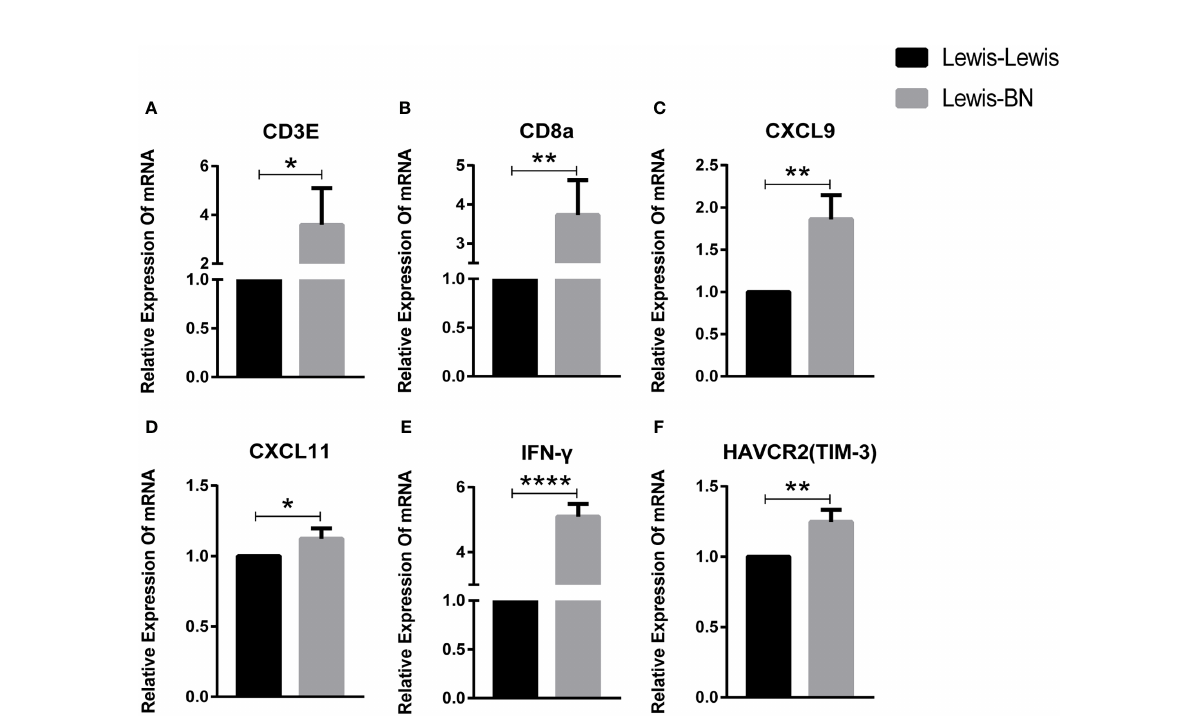
FIGURE 4 Fold-changes of immune mediators in the liver of homogenic and allogeneic rat liver transplantation recipients were measured by quantitative real-time PCR. *P<0.05, **P < 0.01, ***P < 0.001, ****P <